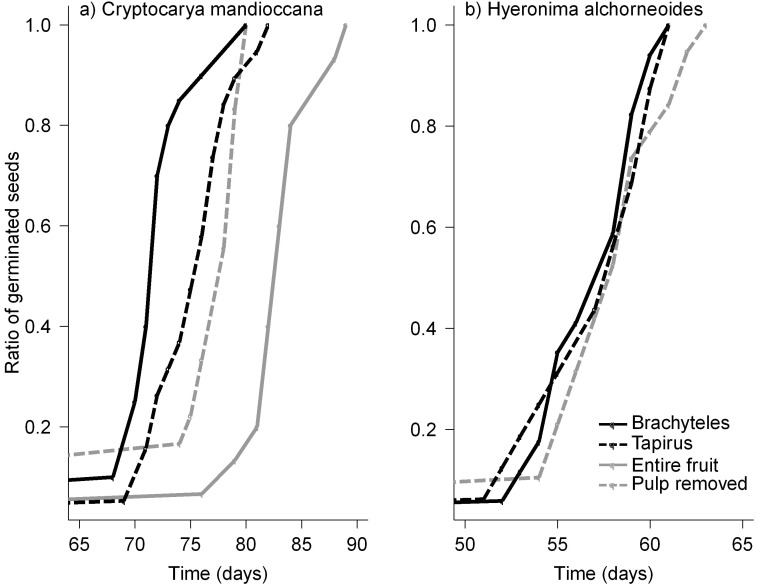
Germination speed of two plant species dispersed by muriquis (Brachyteles arachnoides) or tapirs (Tapirus terrestris) vs. control treatments: Cryptocarya mandioccana (a) and Hieronyma alchorneoides (b).